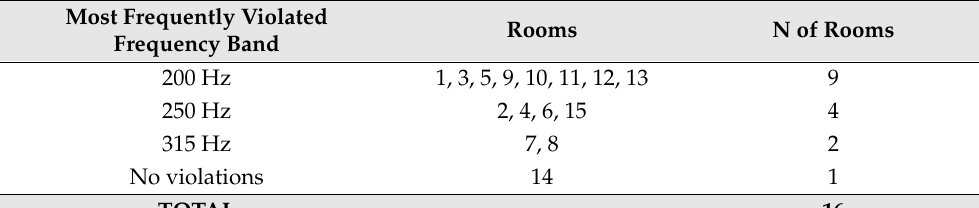
Table 2. Most violated frequency bands for each room without quasi-constant violations (rooms 1 to 16).